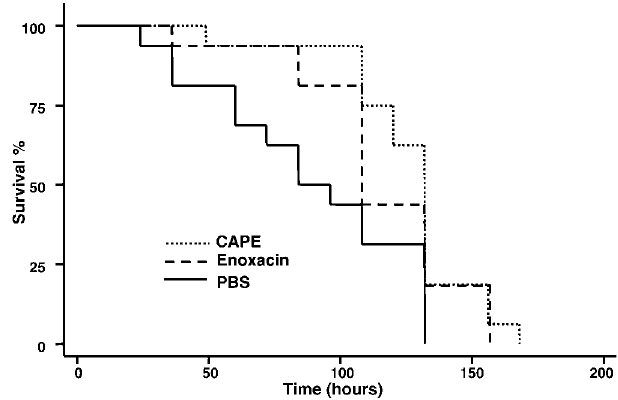
Figure 9. Compounds Identified in the C. elegans Screen Have Activity in a Murine Model of Hematogenous Candidiasis Survival of mice after tail vein injection of 1 3 10 6 blastospores of C. albicans DAY185. Mice that received intravenous injection of CAPE (400 mg/kg once as a loading dose, followed by 200 mg/kg maintenance twice daily) or enoxacin (80 mg/kg loading dose, followed by 40 mg/kg maintenance twice daily) survived significantly longer compared to control mice that received placebo ( p ¼ 0.008 and 0.04, respectively). There were 16 mice in each group. doi:10.1371/journal.ppat.0030018.g009 PLoS Pathogens |